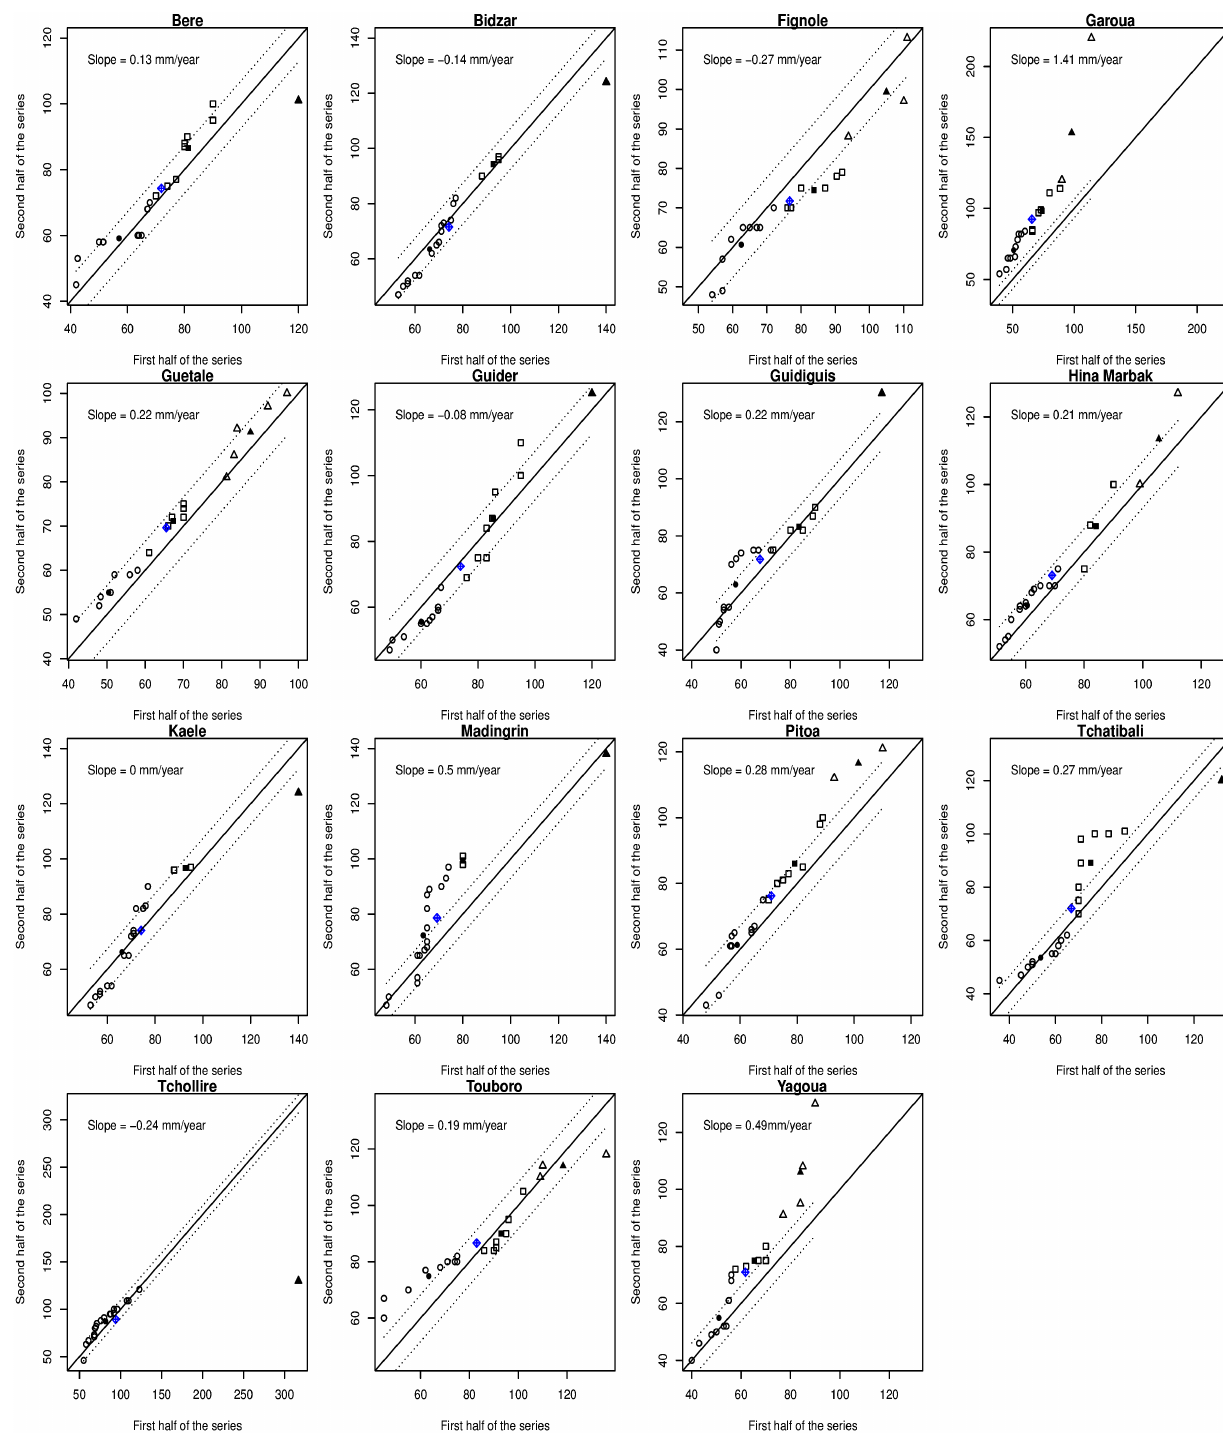
Figure 6. As in Figure 5, but for Rx1day.